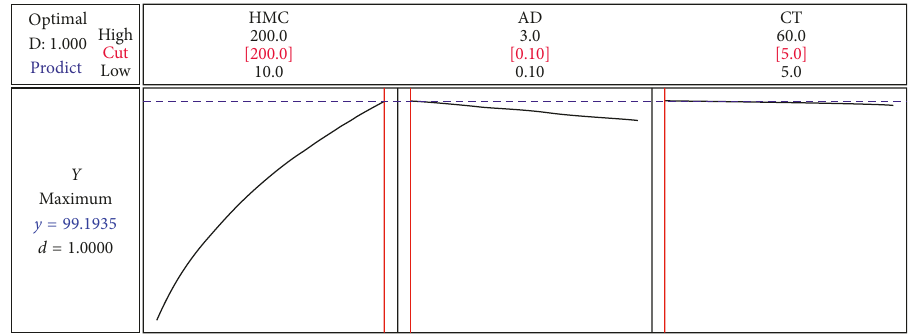
Figure 6: Optimization plots. Optimal values are represented by the vertical solid